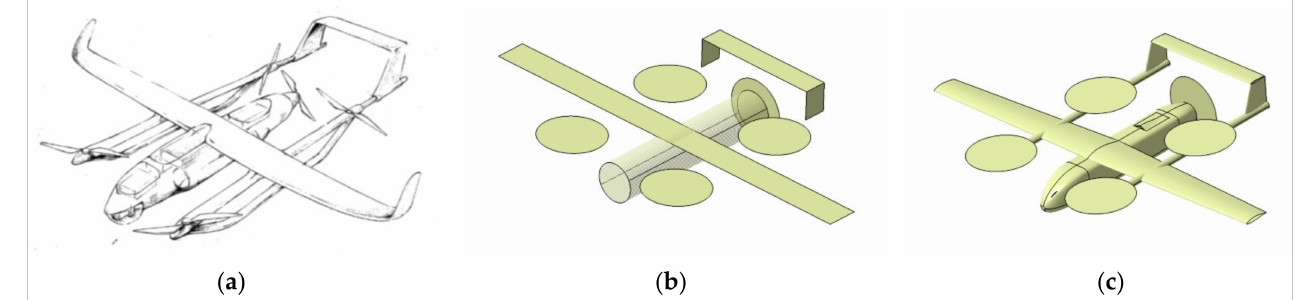
Figure 17. Configuration change of each design stage: ( a ) concept sketch of multi-mode UAV [39]; ( b ) sizing results that include tail sizing results; ( c ) optimum configuration optimized by